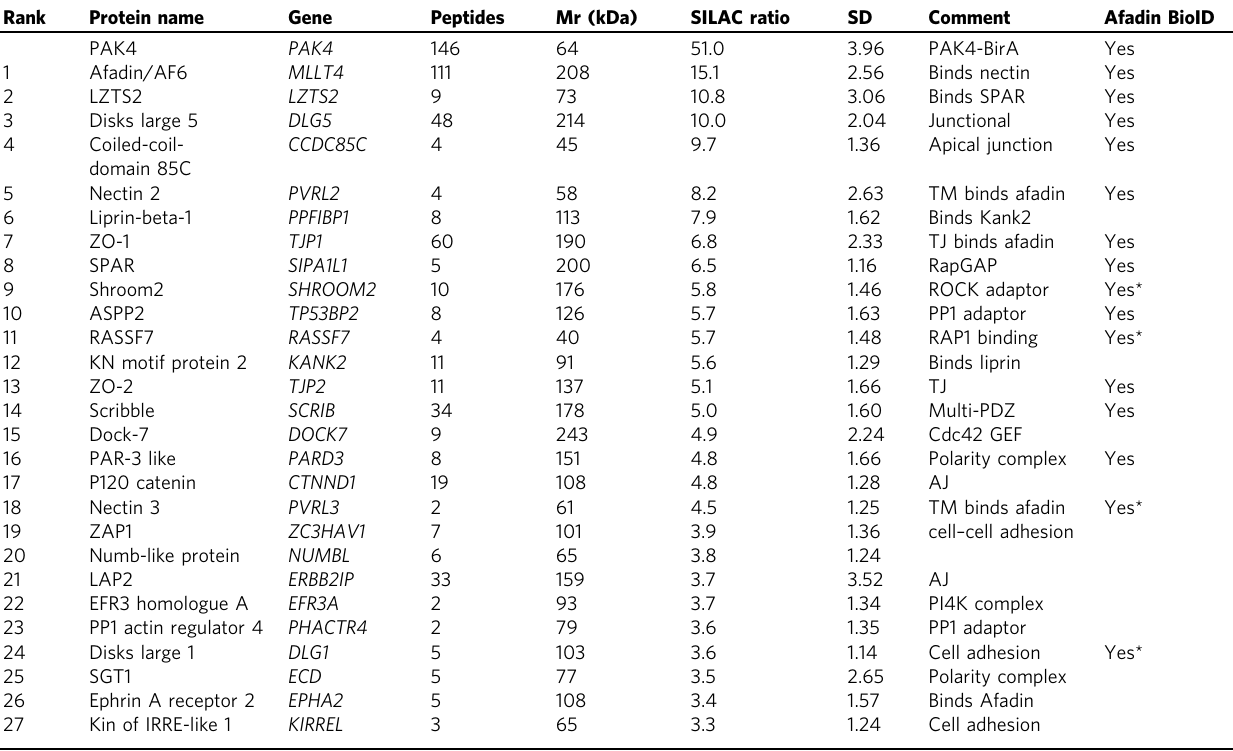
Table 1 List of SILAC-enriched PAK4-proximal proteins. Rank Protein